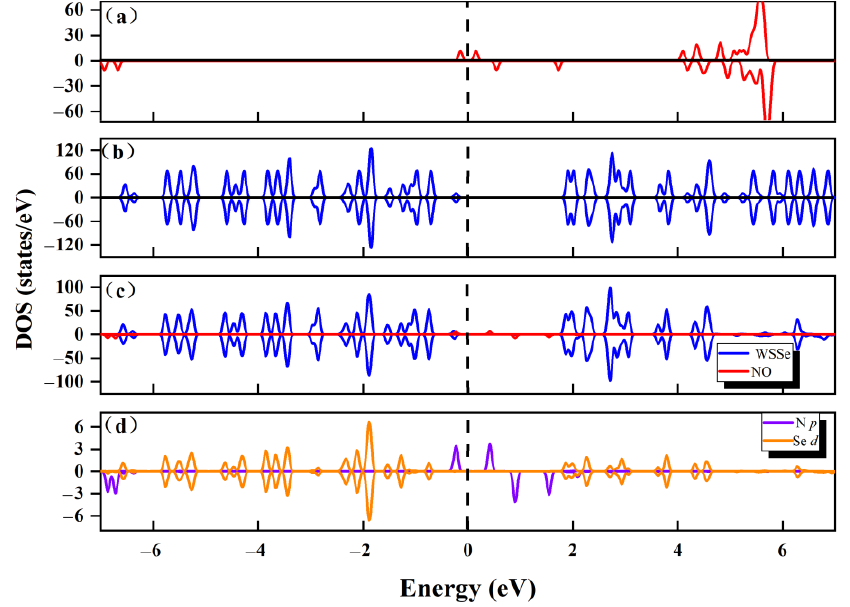
Figure 3. Total DOS of ( a ) a free NO molecule, as well as ( b ) a pure pristine WSSe. ( c ) The adsorption system’s partial DOS. Dark blue is used to represent the WSSe component while red is used to represent the NO portion. ( d ) N p orbitals (marked in purple) of the adsorbed NO and Se p orbitals (marked in orange) of the Se atoms most near adsorbed NO molecule. The Fermi level is indicated by the perpendicular dashed line.